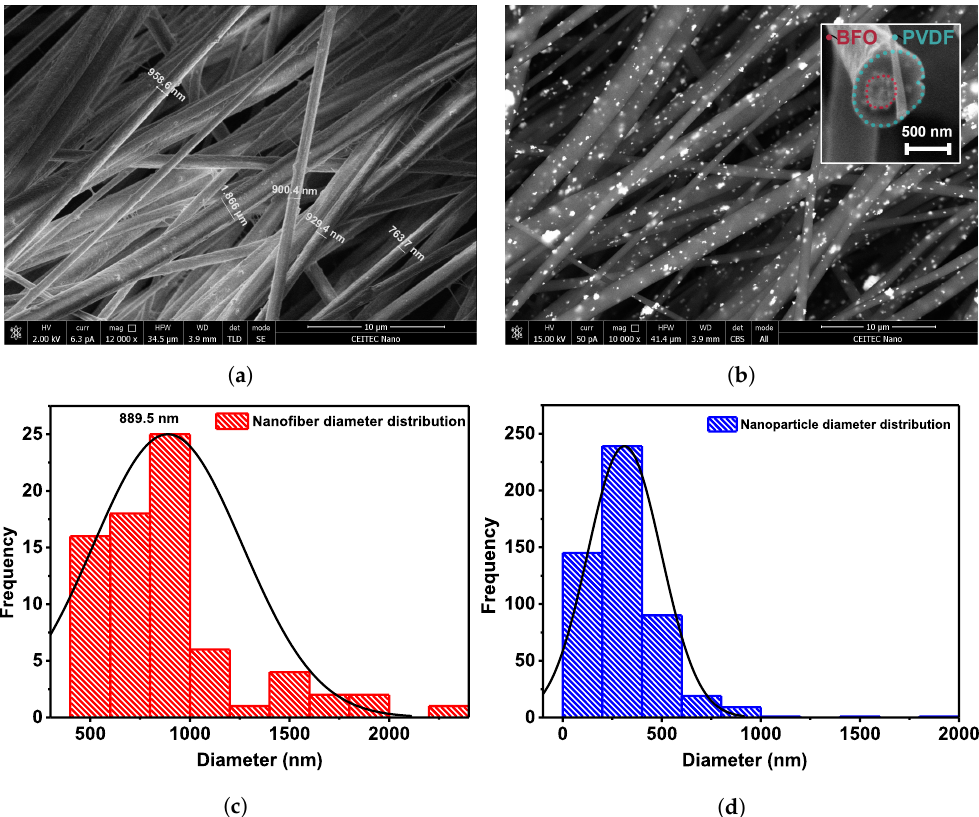
Figure 1. ( a , b ) SEM images of PVDF/BFO fibers. ( c ) Nanofiber diameter distribution and ( d ) nanopar- ticle size distribution